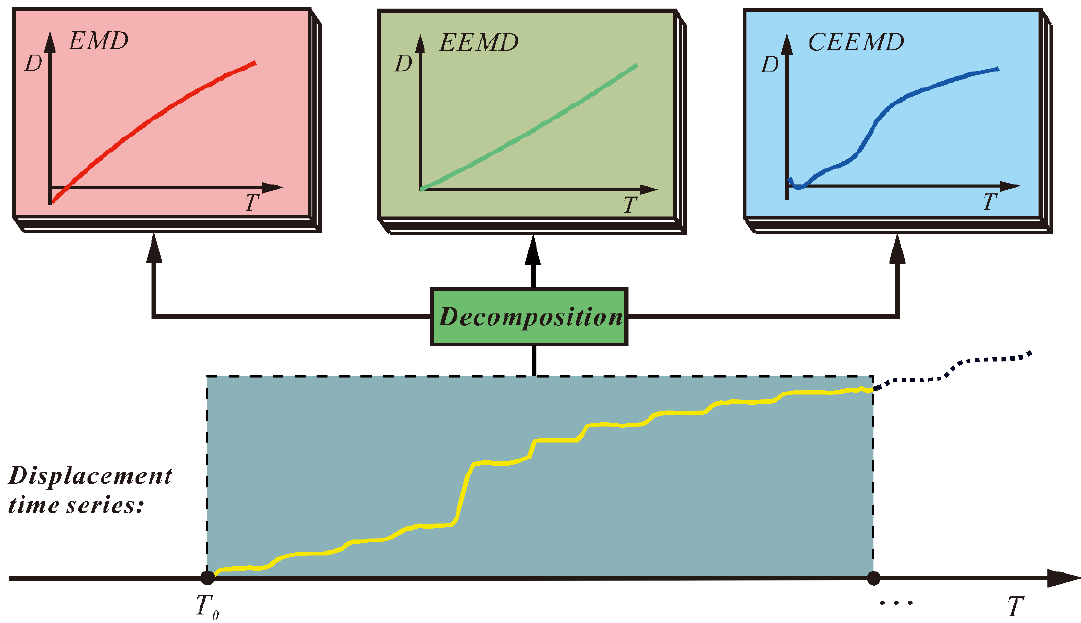
Figure 1. Residual terms of Baishuihe landslide displacements obtained through EMD, EEMD, and CEEMD. The screening of input parameters for an SVR model from related factors is an im- portant part of prediction model optimization. Grey relational analysis (GRA) is a usual approach for this and has achieved convincing results [43]. Meanwhile, many other statisti- cal methods such as maximal information coefficient (MIC) [23] and mean influence value (MIV) [44] have also been tried for this purpose. Zhang et al. [25] found that, as a similarity measuring method of time series, dynamic time warping (DTW) can be employed and works well in optimal input parameters selection of the SVR model. However, the DTW has the limitation of insensitive to the noise of the time series. To overcome this, the edit distance on real sequence (EDR) has been chosen and utilized in this study [45]. The EDR method is a classic trajectory similarity measurement that calculates the minimal number